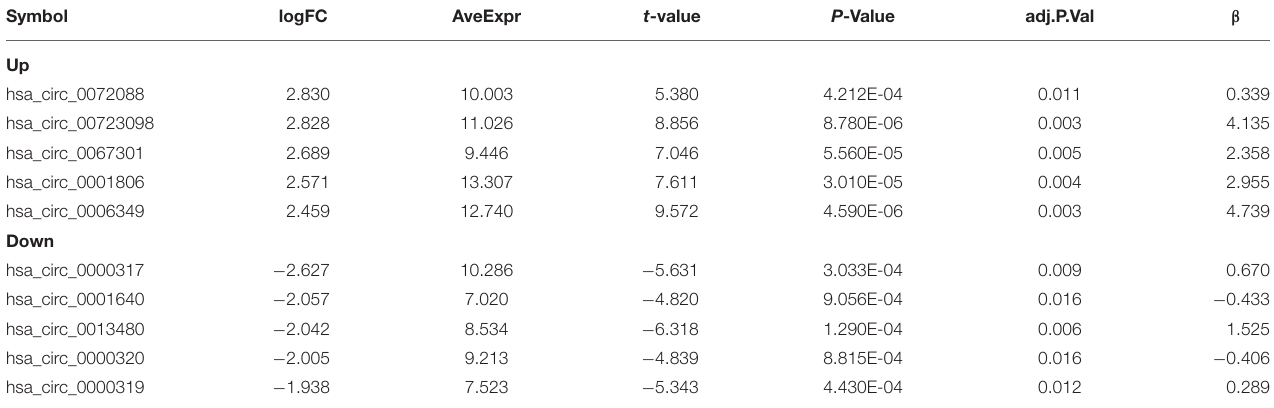
TABLE 1 | The top five up- down-regulated circRNAs in the GSE101684 microarray.